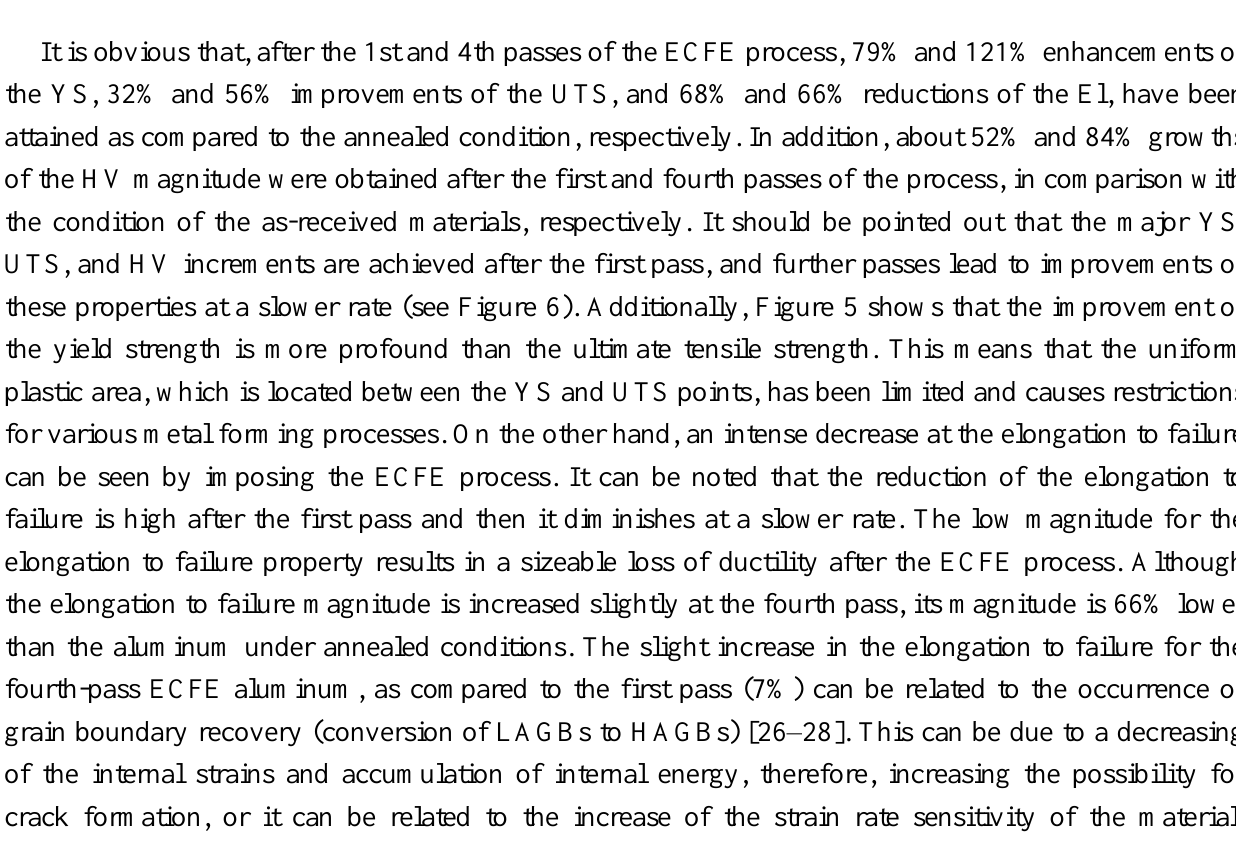
Figure 5. The engineering stress–strain curves for CP aluminum billets after the ECFE process, up to four